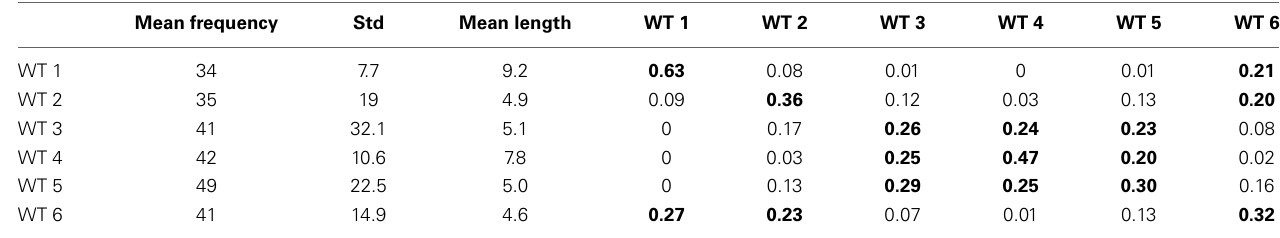
Table 1 | Mean statistics of the length and transitions between the six